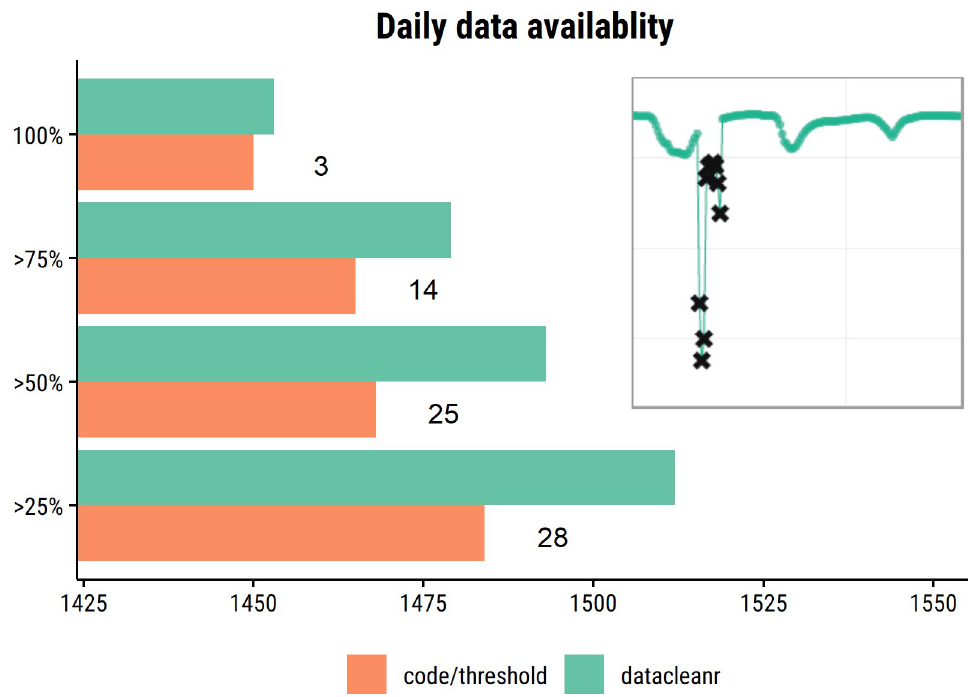
Fig 9. Comparison of code-based and interactive processing with datacleanr of raw sap flux data. Compared to often more tedious, code-based filtering, the interactive quality control using domain expertise allowed retaining more observations resulting in greater data coverage across days (x-axis) for the measurement campaign, which lasted a total of 2769 days. Here, three additional full days of measurements, as well as several additional days with varying partial coverage were retained, as indicated by text labels to the right of bars (completeness by day; e.g. 25% of all measurements for a given day). This is because individual, problematic observations could be removed interactively (see inset), which may increase explanatory power in subsequent